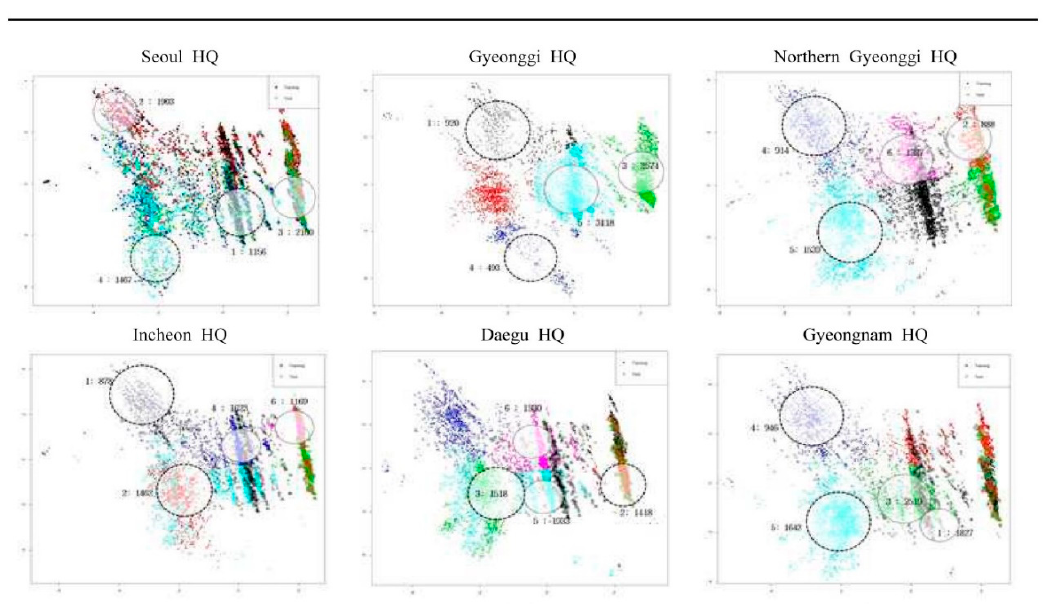
Figure 3. Result of DBSCAN clustering.